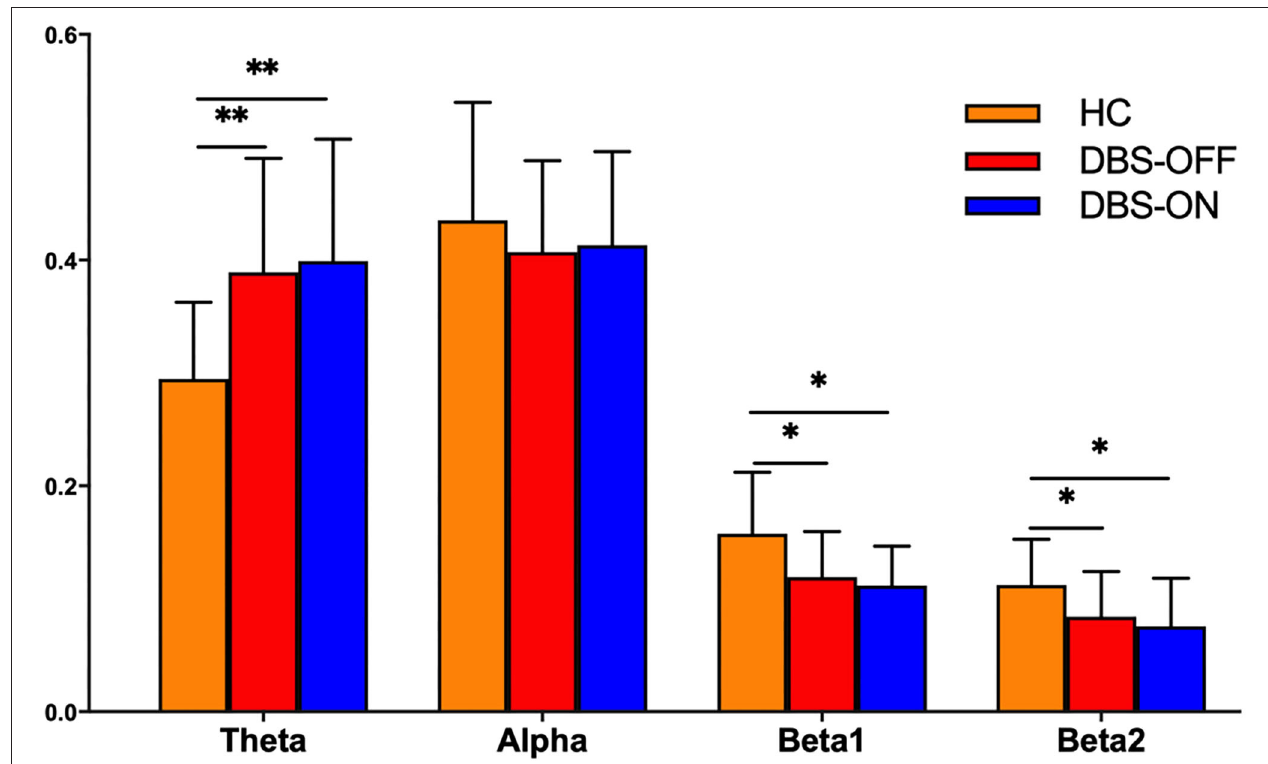
FIGURE 1 | The power-based topology analysis: statistics of power spectral density for each group of patients and healthy controls at four frequency bands: theta (4–8Hz), alpha (8–13Hz), beta1 (13–20Hz), and beta2 (20–30Hz). The * denotes a p < 0.05 and ** denotes a p <